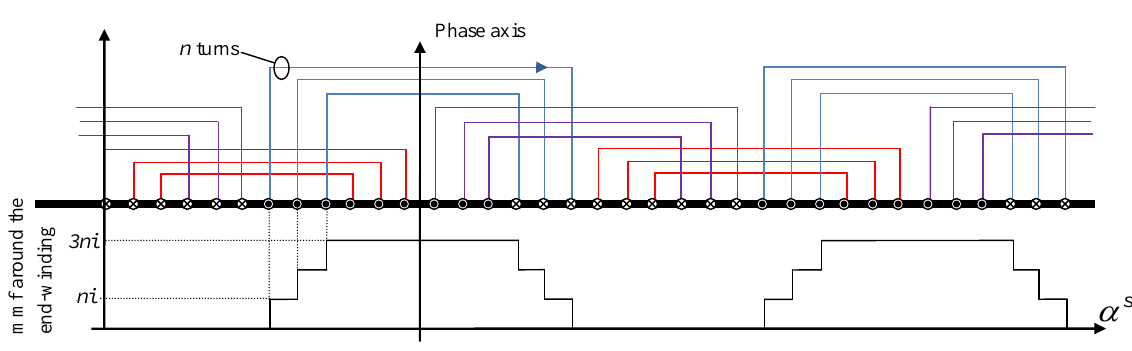
Figure 6. mmf generated by one supplied phase.